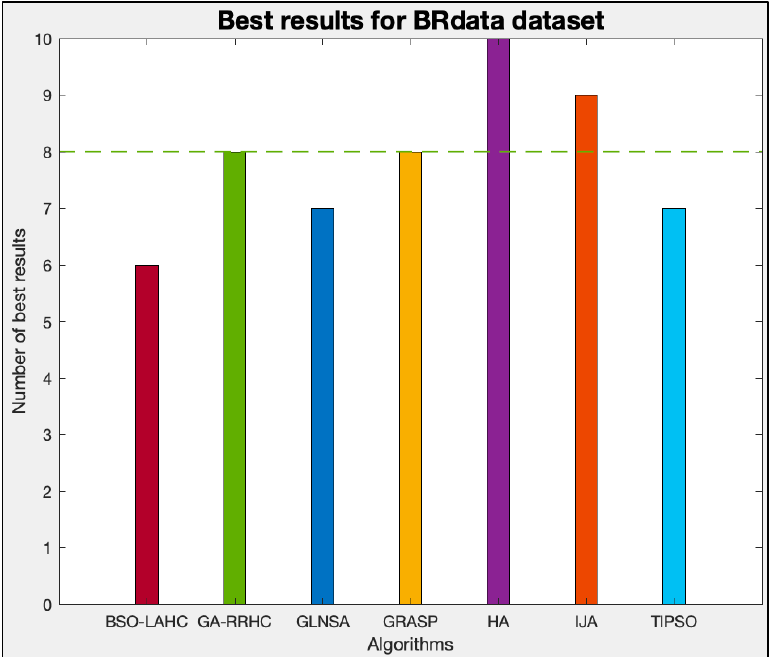
Figure 14. Number of best results per algorithm for the BRdata dataset.